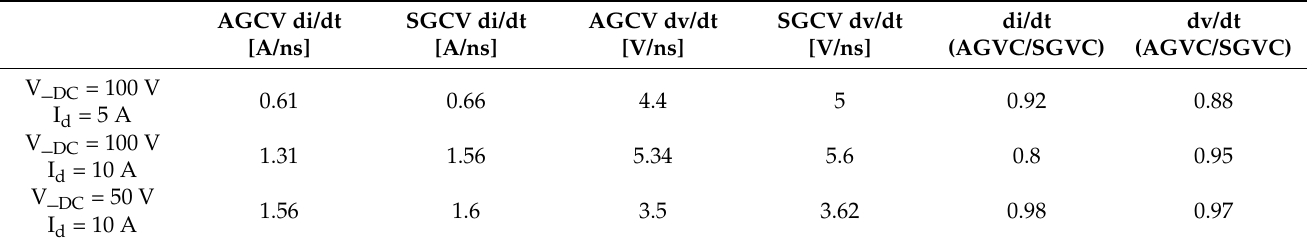
Table 3. Performances of closed loop of AGVC and standard gate control circuits during the turn-off. Figure 21. Input signal of V gr2 .